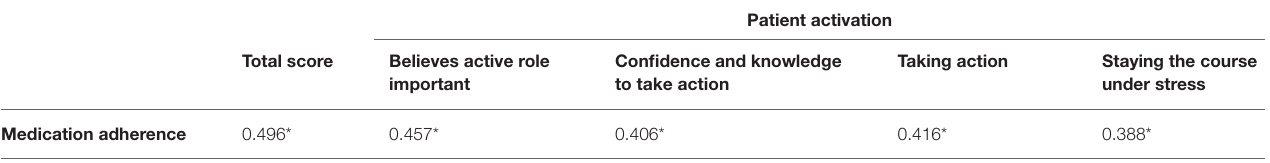
TABLE 5 | Correlation between patient activation and medication adherence in patients with stroke ( n = 119).